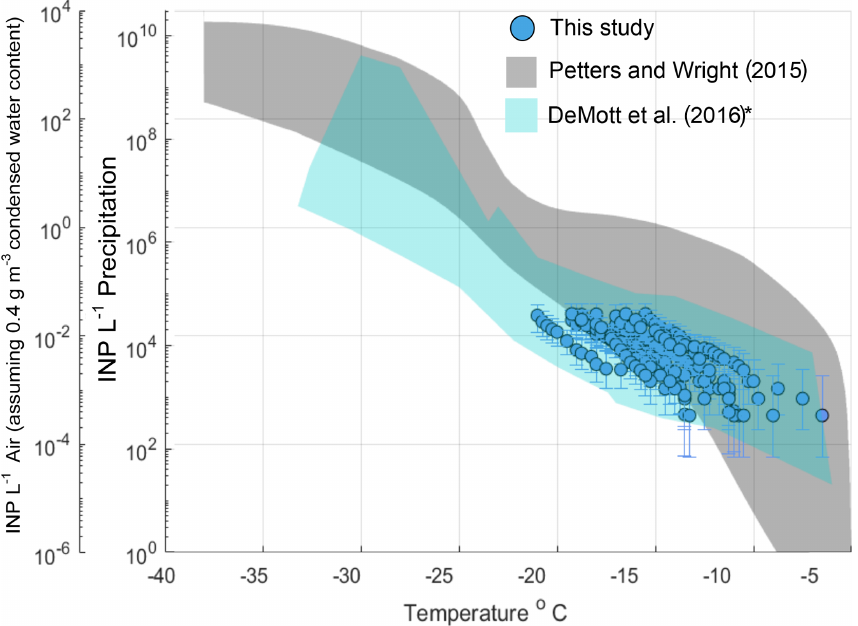
Figure 1. INP concentrations per liter precipitation and estimated in-cloud INP concentrations per volume of air in 11 precipitation samples collected at Scripps Institution of Oceanography Ellen Browning Scripps Memorial Pier (32.8662 ◦ N, 117.2544 ◦ W; La Jolla, California, USA) between March and May 2016. The gray shaded region indicates the spectrum of INP concentrations reported in nine previous studies on precipitation and cloud water samples collected from various seasons and locations worldwide, adapted from Fig. 1 in Petters and Wright (2015). The blue shaded region represents the composite spectrum of INP concentrations observed in a range of marine and coastal environments including the Caribbean, the eastern Pacific and the Bering Sea as well as laboratory-generated nascent sea spray (DeMott et al., 2016). ∗ DeMott et al. (2016) data have been updated with a complete dataset from the Ice in Clouds – Tropical (ICE-T) study, as shown in Yang et al.